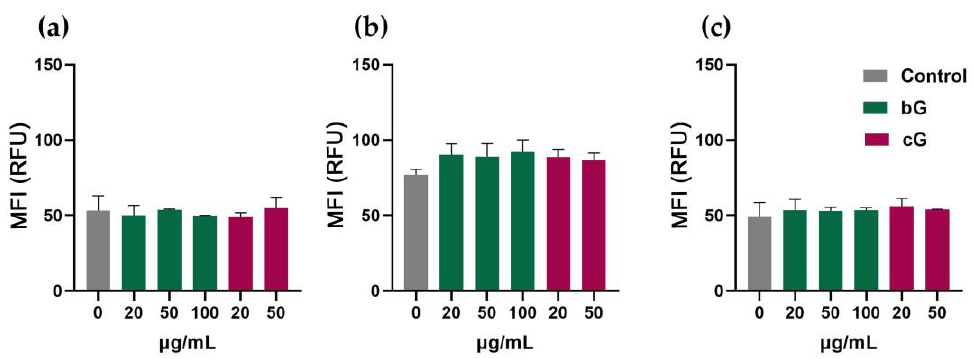
Figure 5. ROS formation after treatment of cells with three doses of bG (20, 50 and 100 μg/mL) or two doses of cG (20 and 50 μg/mL) for 24 h in NIH/3T3 ( a ), HaCaT ( b ) and THP-1 cells ( c ). MFI, mean fluorescence intensity. RFU, relative fluorescence units.